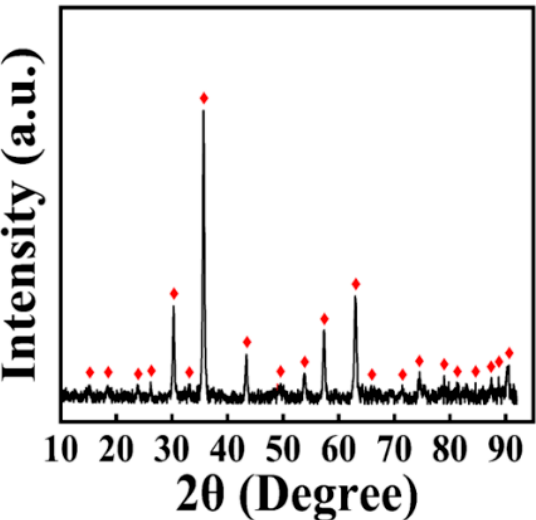
Figure 1. X-ray diffraction pattern of as received Fe 2 O 3 powder ( ♦— peaks corresponding to JCPDS file 025-1402 of γ -Fe 2 O 3 phase).